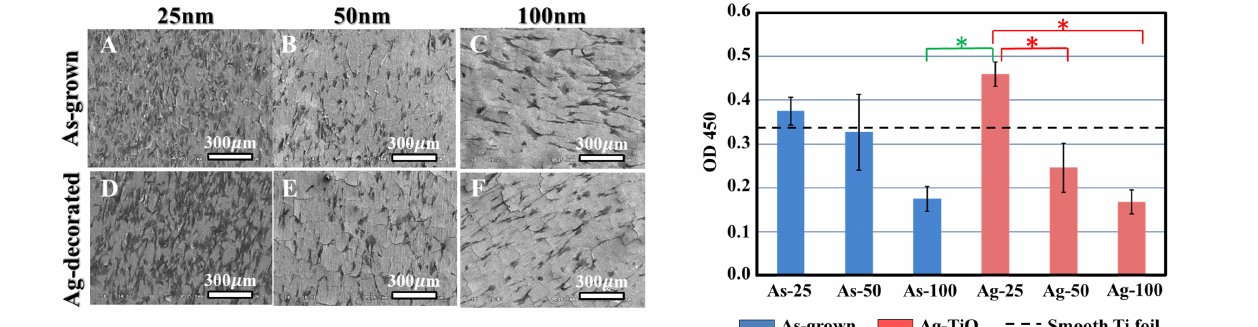
Figure 10. Optical densities (OD) measured after the culture of human fibroblast cells on the as-grown and Ag-decorated TiO 2 nanotubes of different diameters. Cell proliferation was lowest for the largest diameter of 100 nm in both the as-grown and Ag-decorated TiO 2 nanotubes. Meanwhile, the 25-nm-diameter Ag-decorated sample showed the highest OD value of all nanotube samples. Data were means 6 SE of three independent experiments (* p , 0.01 ).